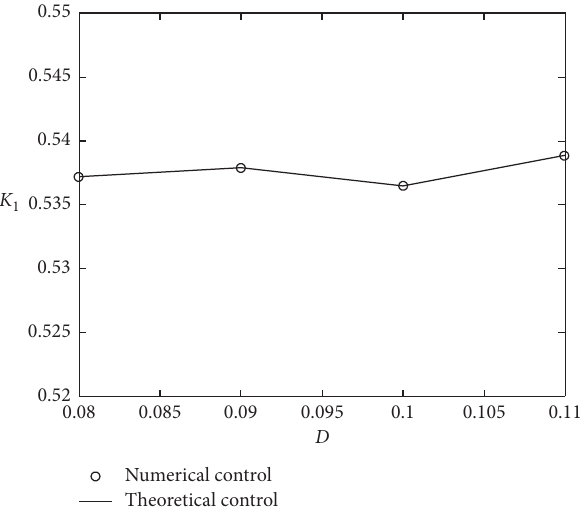
Figure 7: Control effectiveness K